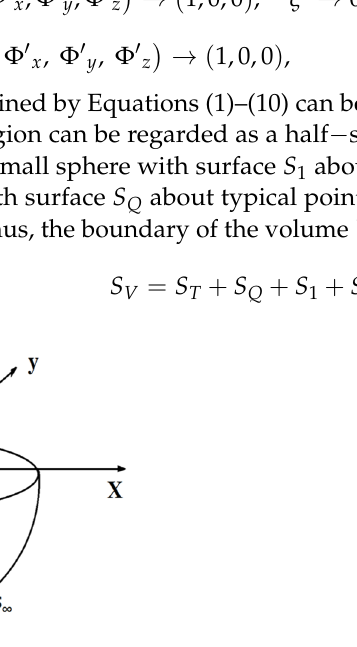
Figure 2. Schematic diagram of the fluid volume and its bounding surface.